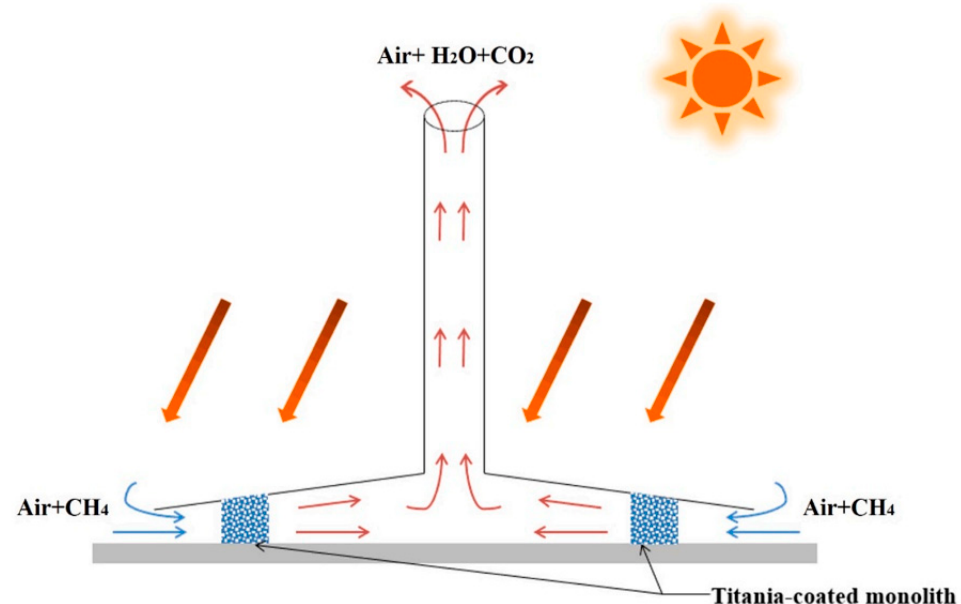
Figure 2. Schematic of the SCPP-PCRs [33].